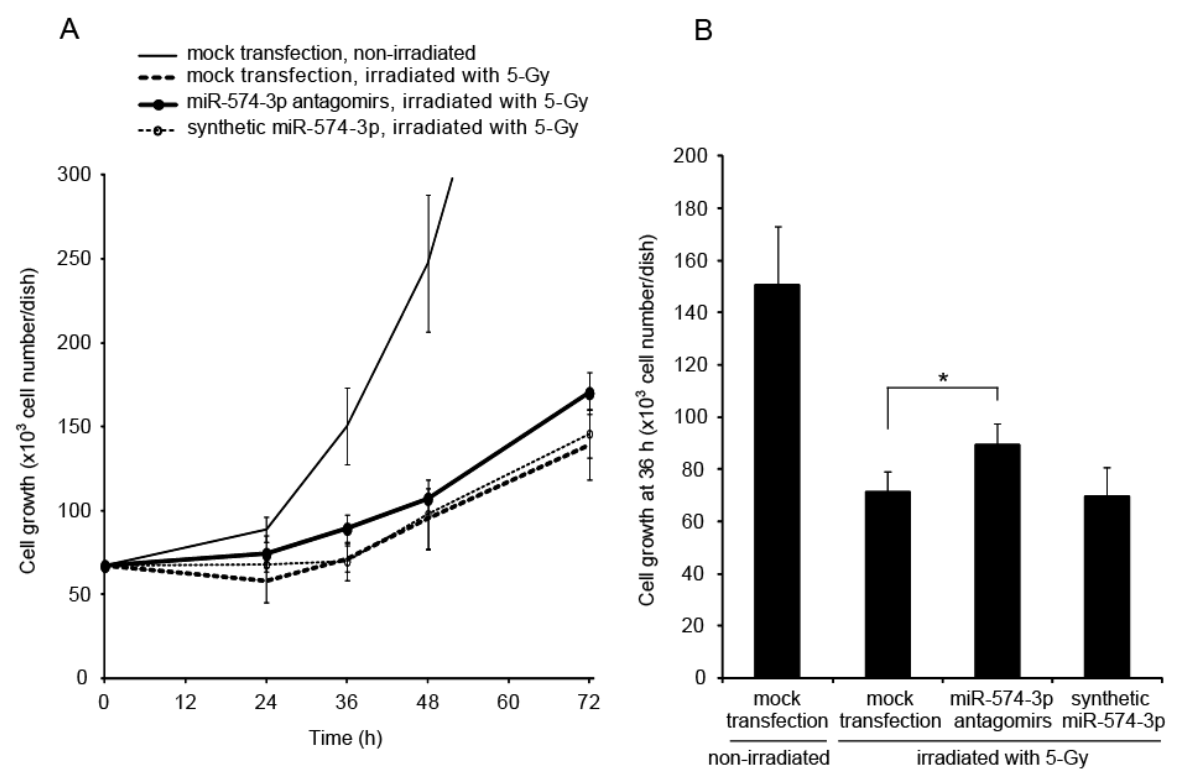
Figure 4. Attenuation of X-ray-induced growth delay in A549 cells through suppression of miR-574-3p. ( A ) A549 cells were transfected with 20 nM miR-574-3p antagomirs or synthetic miR-574-3p. Cells transfected with the miR-574-3p antagomirs or synthetic miR-574-3p were incubated for 24 h and then irradiated with 5-Gy of X-ray. X-irradiated cells were seeded on 35-mm dishes at a density of 67,000 cells per dish. Cells were counted using a hemocytometer at 24, 36, 48, or 72 h after irradiation. Each experiment was conducted three times; ( B ) Cell growth was assessed using the cell number at 36 h. * Statistical difference with p < 0.05 was considered